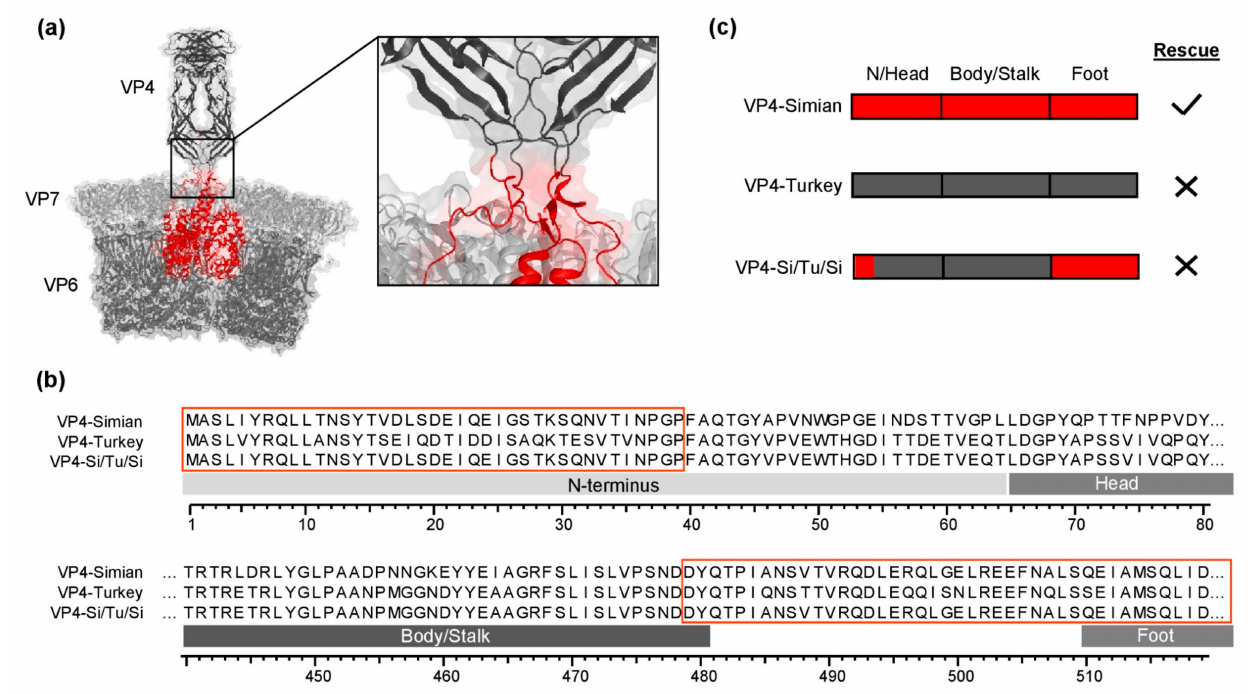
Figure 1. Chimeric simian/turkey VP4. ( a ) Schematic representation of the crystal structure of the rotavirus outer capsid layer based on PDB 4V7Q. The amino acid residues located in cavity formed by VP6 and VP7 are shown in red. ( b ) Amino acid sequence alignment of VP4 from simian SA11 (VP4-Simian) and turkey 2E10 (VP4-Turkey) in comparison to the sequence of the chimeric VP4 construct (VP4-Si-Tu-Si). The red boxes correspond to the amino acid residues shown in red in ( a ). ( c ) Schematic representation of VP4-encoding genome segments used for rescue experiments. N/Head: N-terminus and head region, VP4-Simian: red, VP4-Turkey: dark